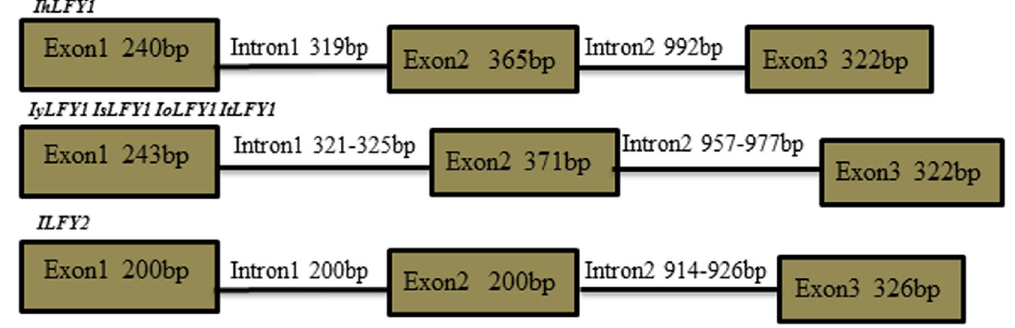
Figure 1. Gene structures of ILFY1 and ILFY2 homologs. Three exons and two introns were shown as green boxes and black lines, respectively. The ILFY1 and ILFY2 sequences were identical for I. yunguiensis , I. sinensis , I. orientalis , and I. taiwanensis . The two introns were variable in the five